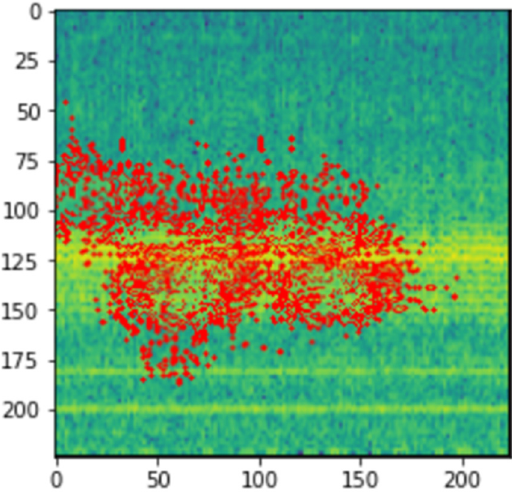
Figure 20. LIME image explainer on abnormal vibrational signal.